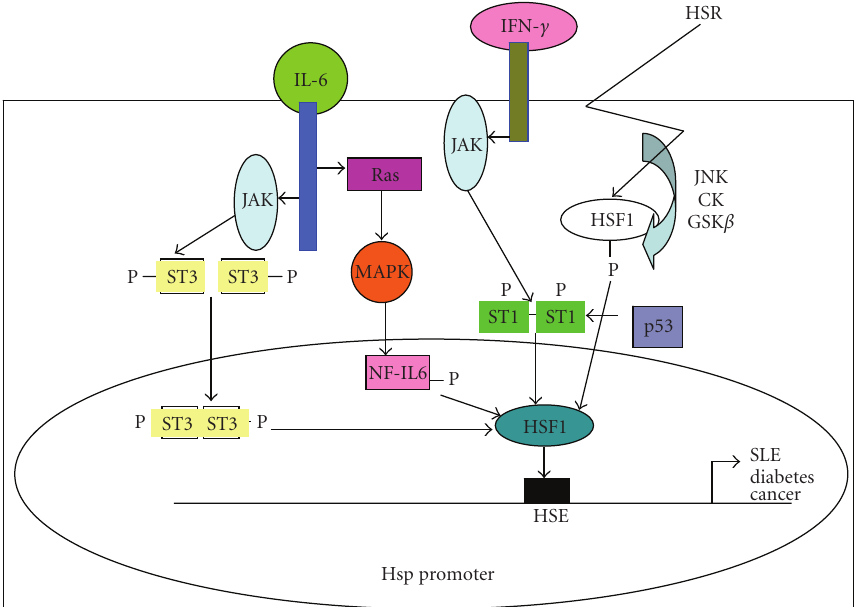
Figure 1: Signal transduction pathways activated by STAT1, STAT3, NF-IL6, p53, and the heat-shock response (HSR) via HSF1 binding to the heat-shock response element (HSE) and integrating to modulate Hsp transcription, which is known to be dysregulation in di ff erent pathological